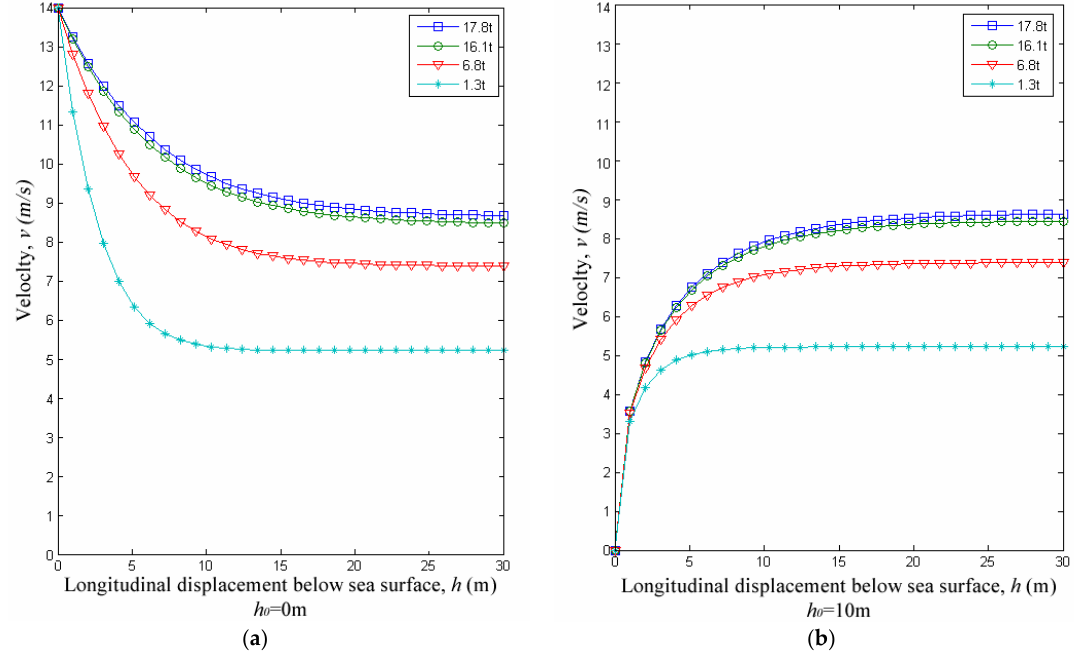
Figure 4. Falling speeds of anchors with different masses (( a ) at altitudes of 0 and ( b ) at altitudes of 10 m).